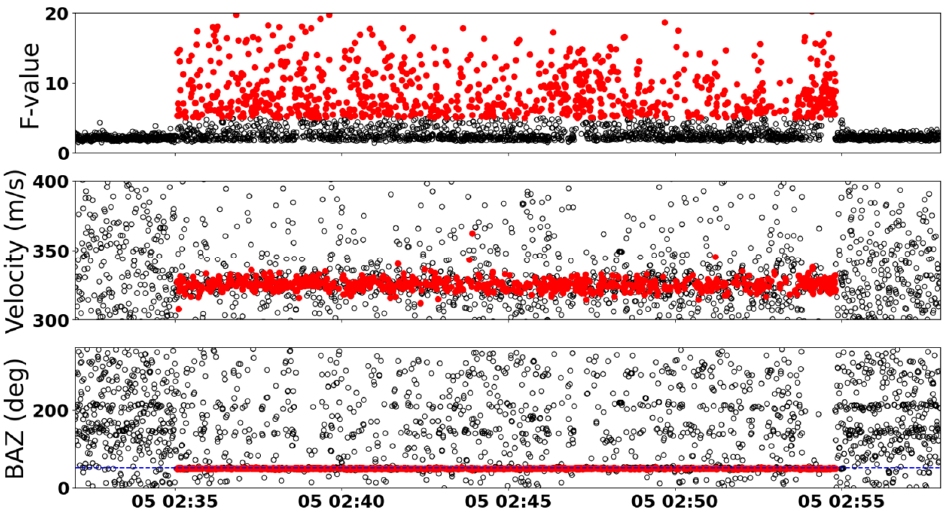
Figure 9. FK analysis results including ( top ) F-value, ( middle ) trace velocity, and ( bottom ) back azimuth during the Stillwater, Oklahoma firework show on 4 July 2018. Closed (red) markers indicate periods with high coherence (i.e., high F-value) and an acoustic trace velocity.